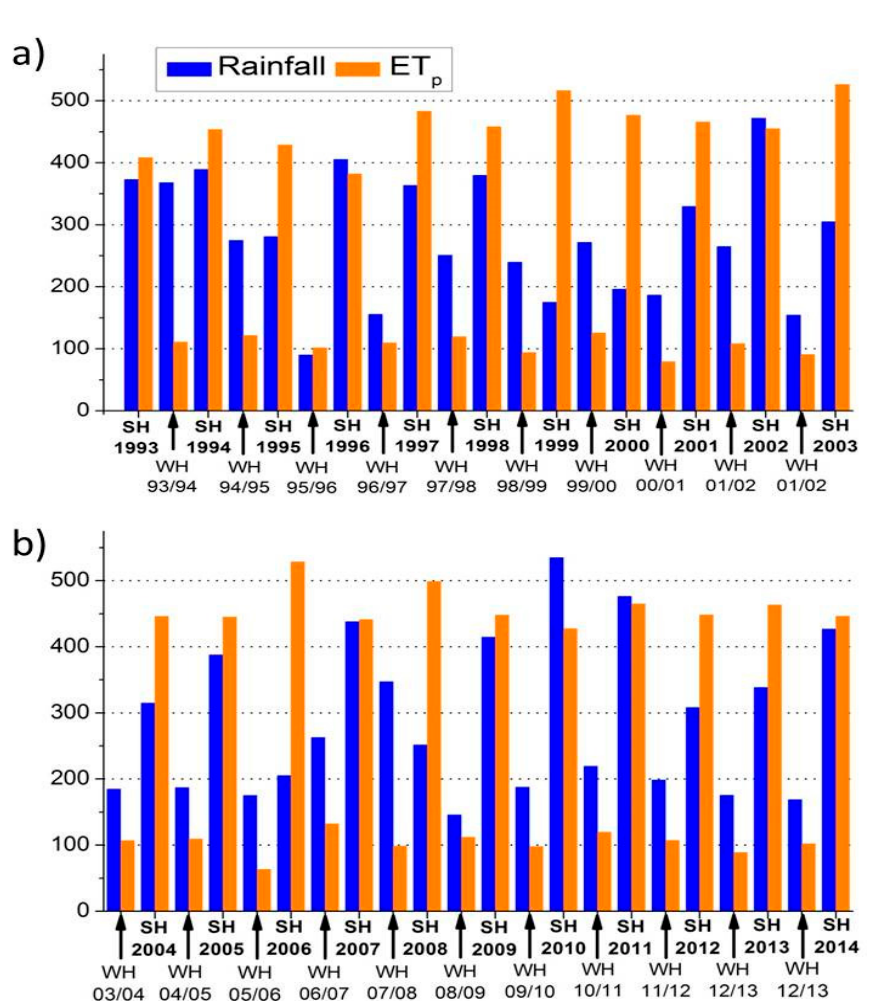
Figure 2. Rainfall and potential evapotranspiration (ET p ) for hydrological summer half years (SH) from May to October and for hydrological winter half years (WH) from November to April: ( a ), 1993–2003; ( b )